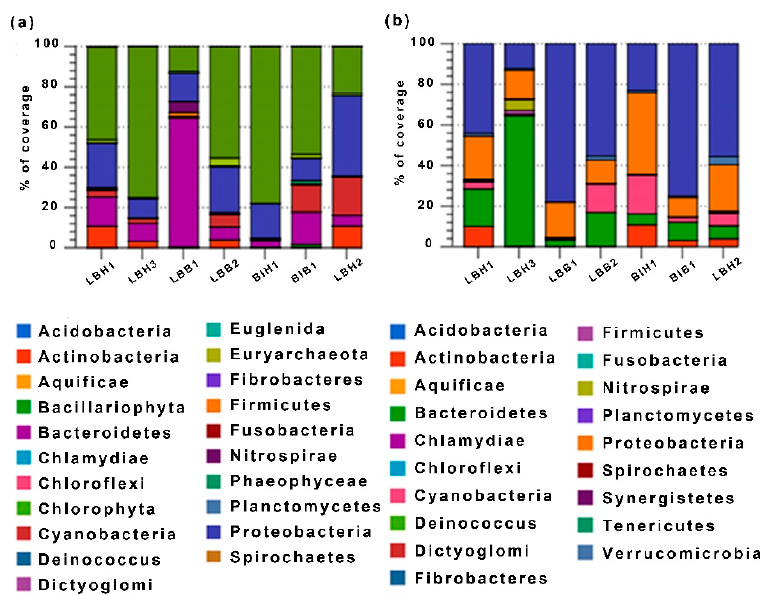
Figure 1. A phylum based bar diagram represents overall reads ( a ) and separated bacterial reads ( b ) classification was predicted among healthy and bleached freshwater sponges Lubomirskia baikalensis and Baikalospongia